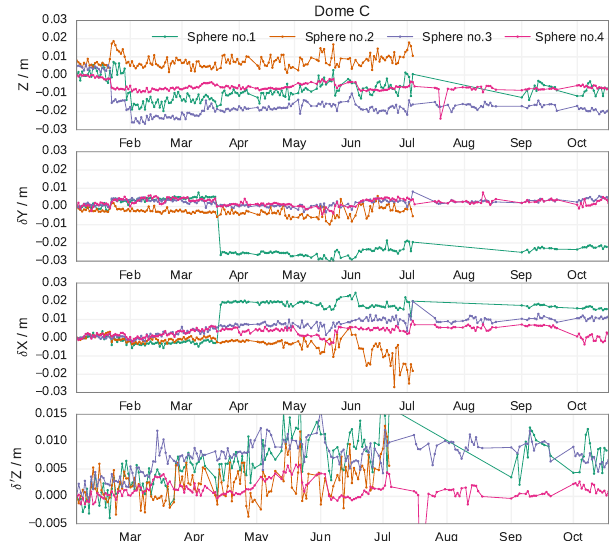
Figure 5. Evolution of the four reference spheres coordinates ( x , y , z ) at Dome C. δ and δ (cid:48) respectively refer to the changes with respect to the first scan (1 January 2015) and to a scan just after a period of settling (1 February 2015).